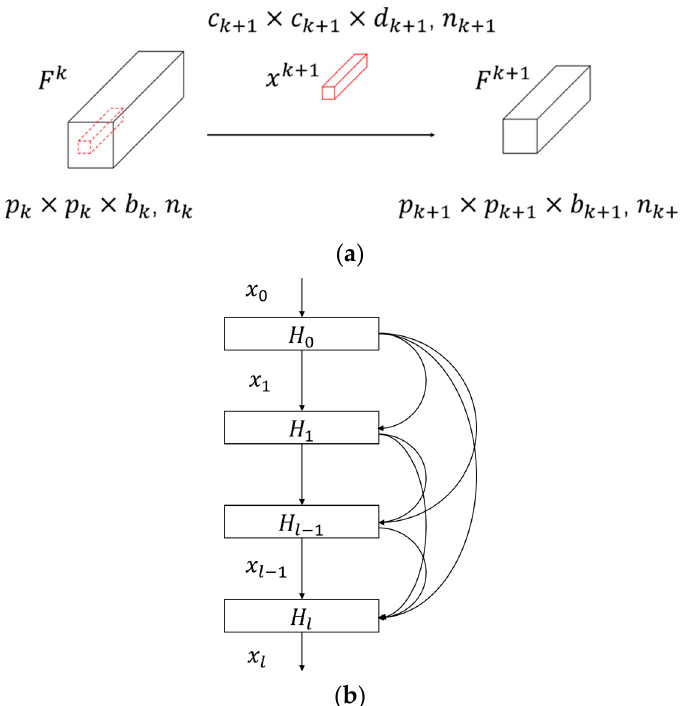
Figure 2. Illustration of ( a ) 3D convolution and ( b ) DenseNet.